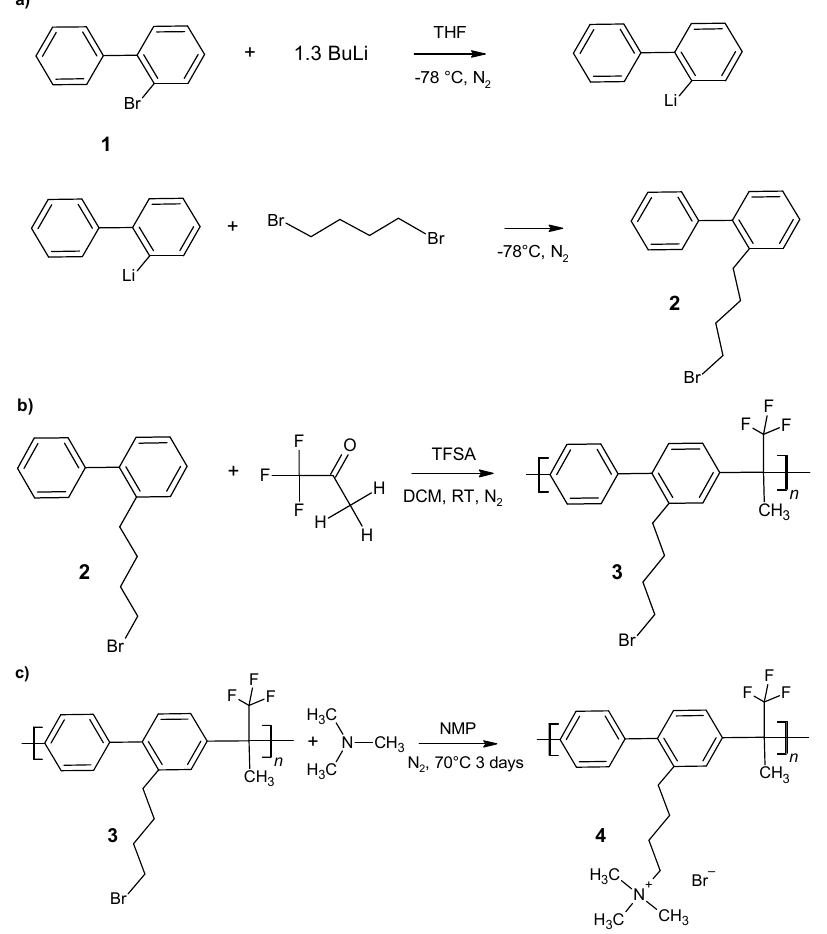
Figure 1. Synthesis scheme: ( a ) 2 ‐ (4 ‐ bromobutyl)biphenyl ( 2 ); ( b ) poly[(2 ‐ (4 ‐ bromobutyl)biphenyl ‐ 4,4 ′‐ diyltrifluoromethylmethylmethylene] ( 3 ); ( c ) ABBA ( 4 ).